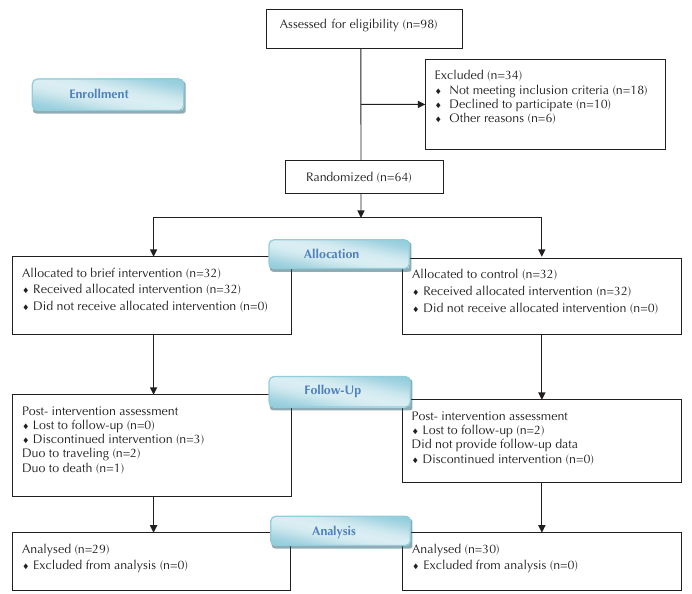
Figure 1 . Flow Diagram of Participants Throughout the